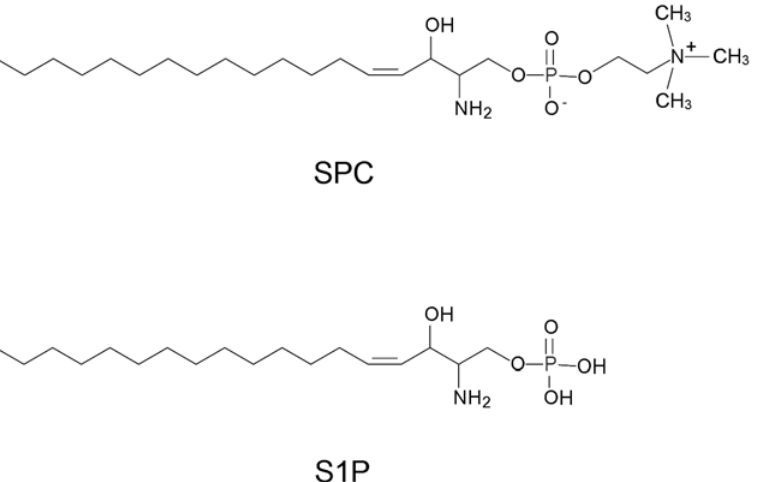
Figure 1. Chemical structures of SPC and